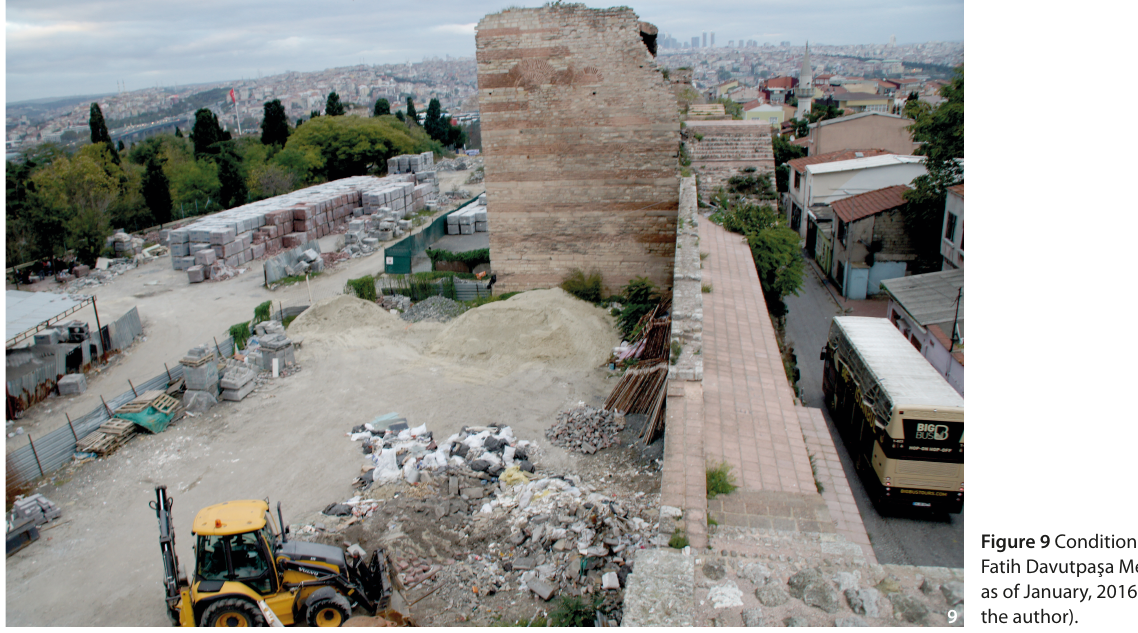
Figure 9 Condition of the Fatih Davutpaşa Medresesi as of January, 2016 (Source: the